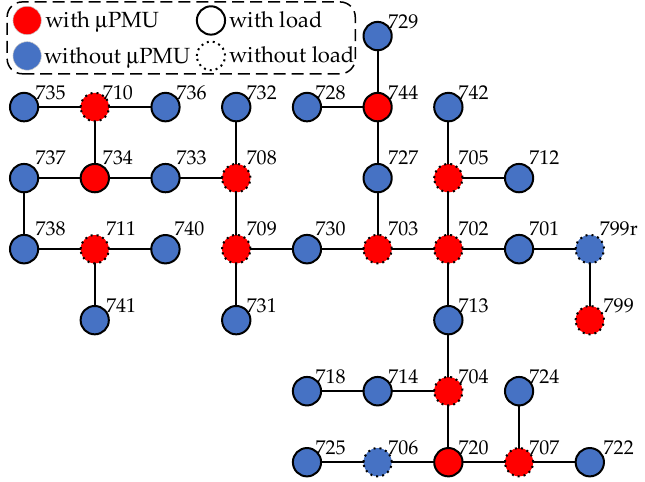
Figure 6. IEEE 37 bus system for test.